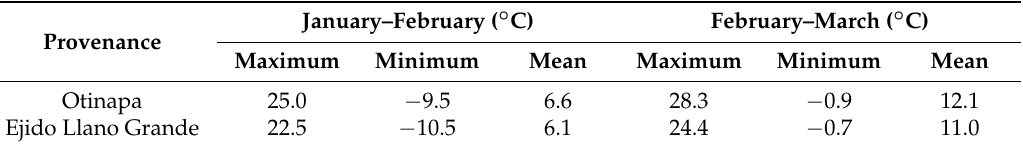
Table 1. Temperature in the two scion collection sites of Pinus engelmannii